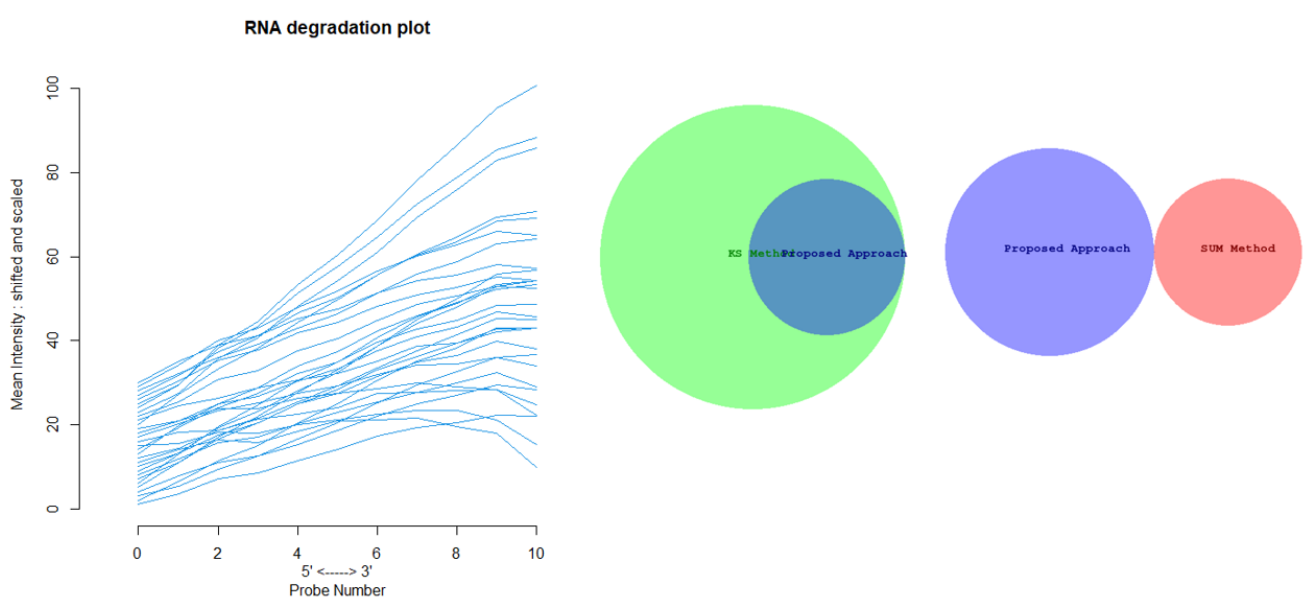
Figure A7. Dataset D: ( left ) outlier degradation plot of detected outliers and ( right ) Euler-Venn diagrams comparing the results obtained by three outlier detection